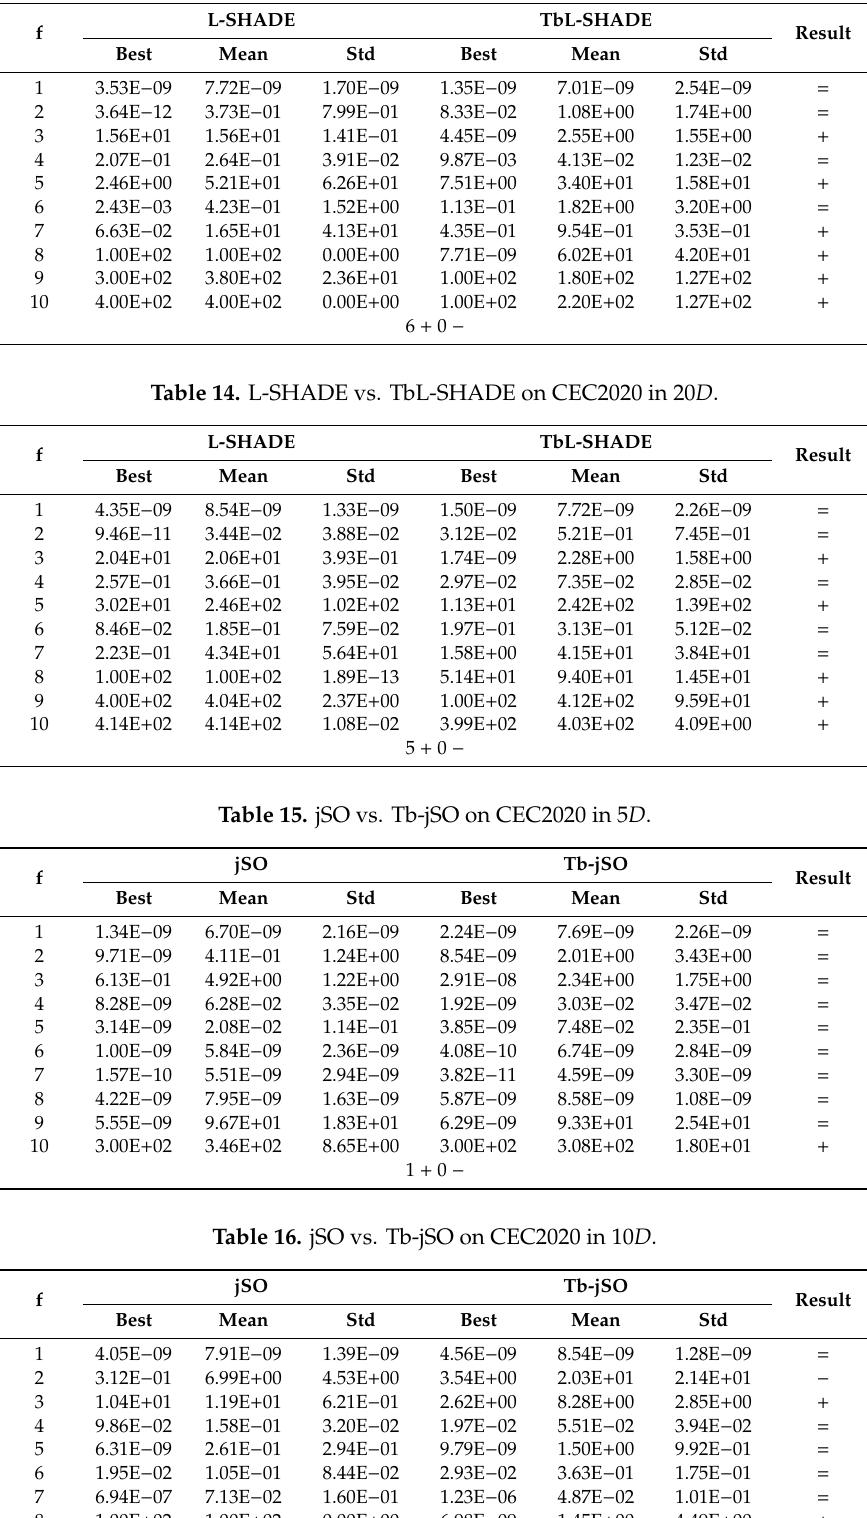
Table 13. L-SHADE vs. TbL-SHADE on CEC2020 in 15 D .